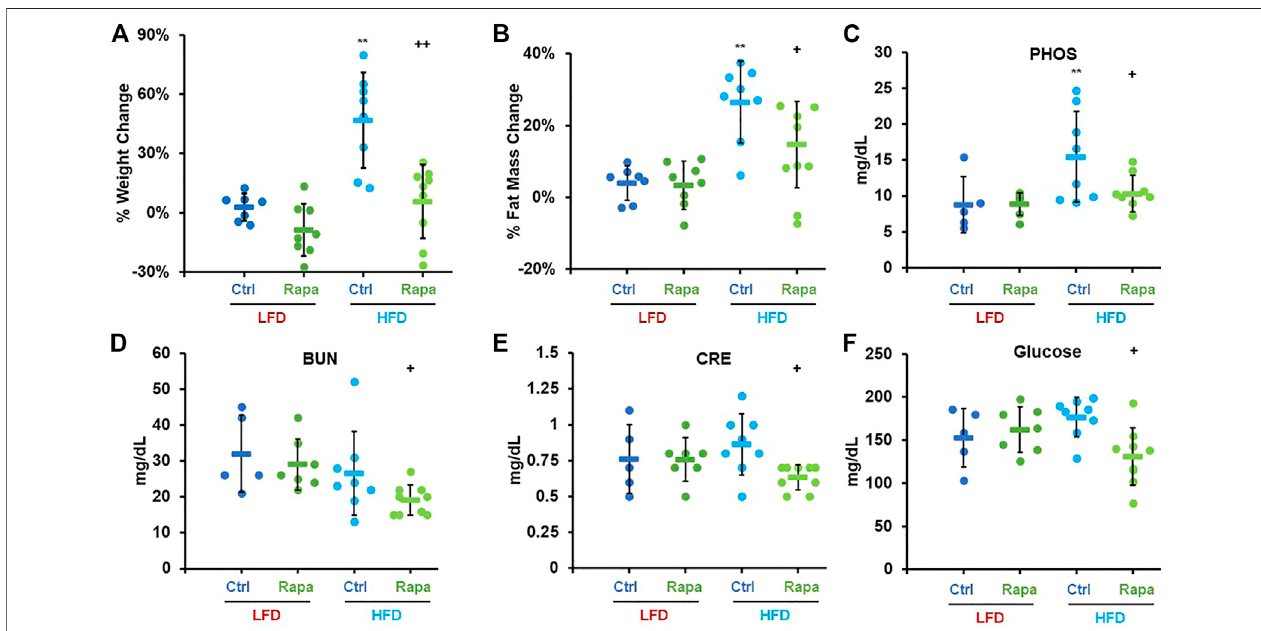
FIGURE 2 | Rapamycin prevents diet-induced obesity in mice. Percent weight (A) and fat mass (B) change in mice fed either a low-fat diet (LFD) or a high-fat diet (HFD). Serum phosphate (C) , blood urea nitrogen (D) , creatinine (E) , and glucose (F) measured after a 24 h fast-3h refeed at the time of necropsy. PHOS: phosphate,